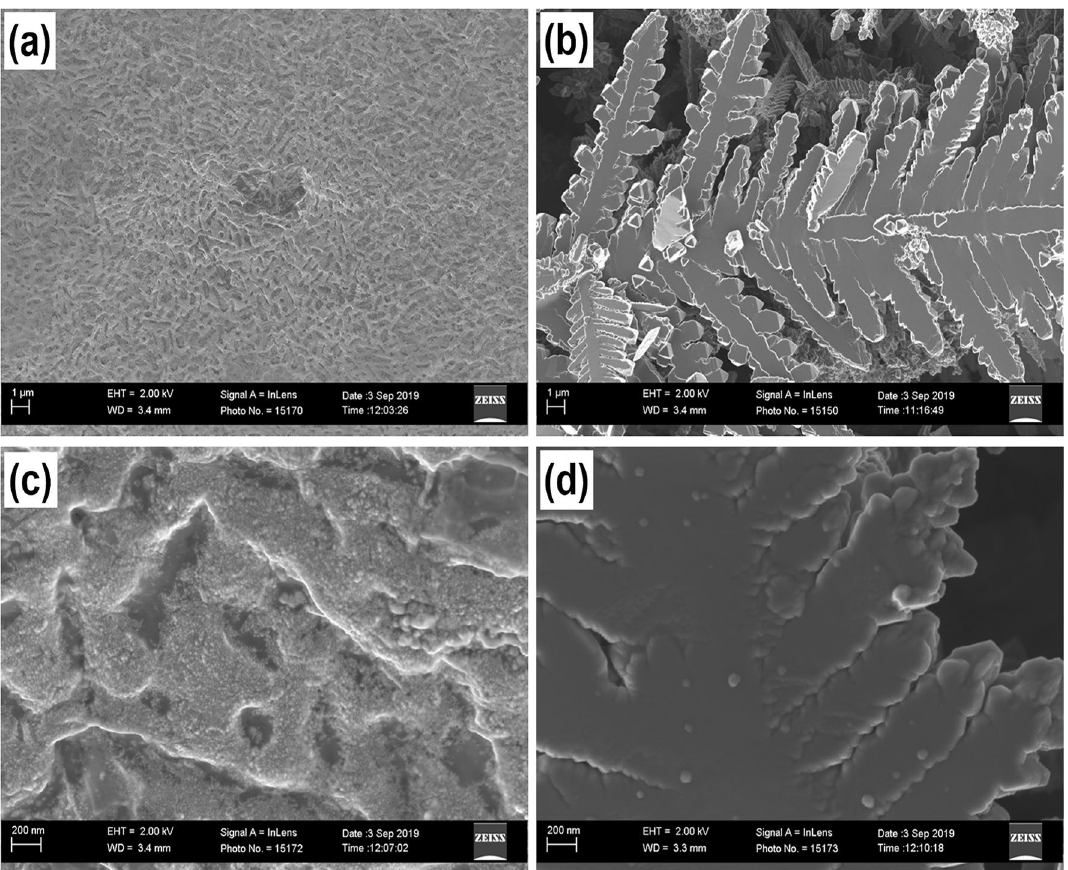
Figure 4. SEM morphology observations at 1 mµ magnification for ( a ) Bio-PdNPs and ( b ) Chem-PdNPs; and at 200 nm magnification for ( c ) Bio-PdNPs and ( d )